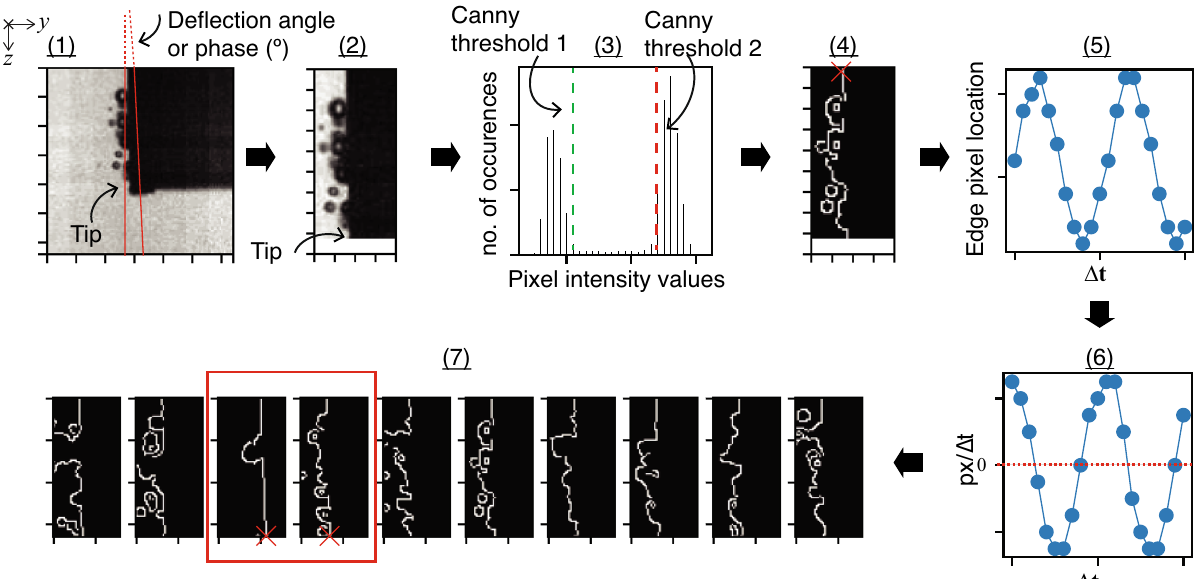
Figure 6. Needle tip deflection was measured using a sequence of frames captured from high-speed camera at 310 kHz, using a 7-step algorithm (1–7), involving cropping (1–2), Canny edge detection (3–4), computation of edge pixel location (5) and its time derivative (6), and finally measuring the peak-to-peak deflection at tip from a visually inspected frame pair